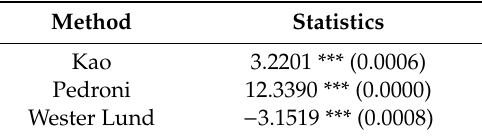
Table 5. Results of co-integration